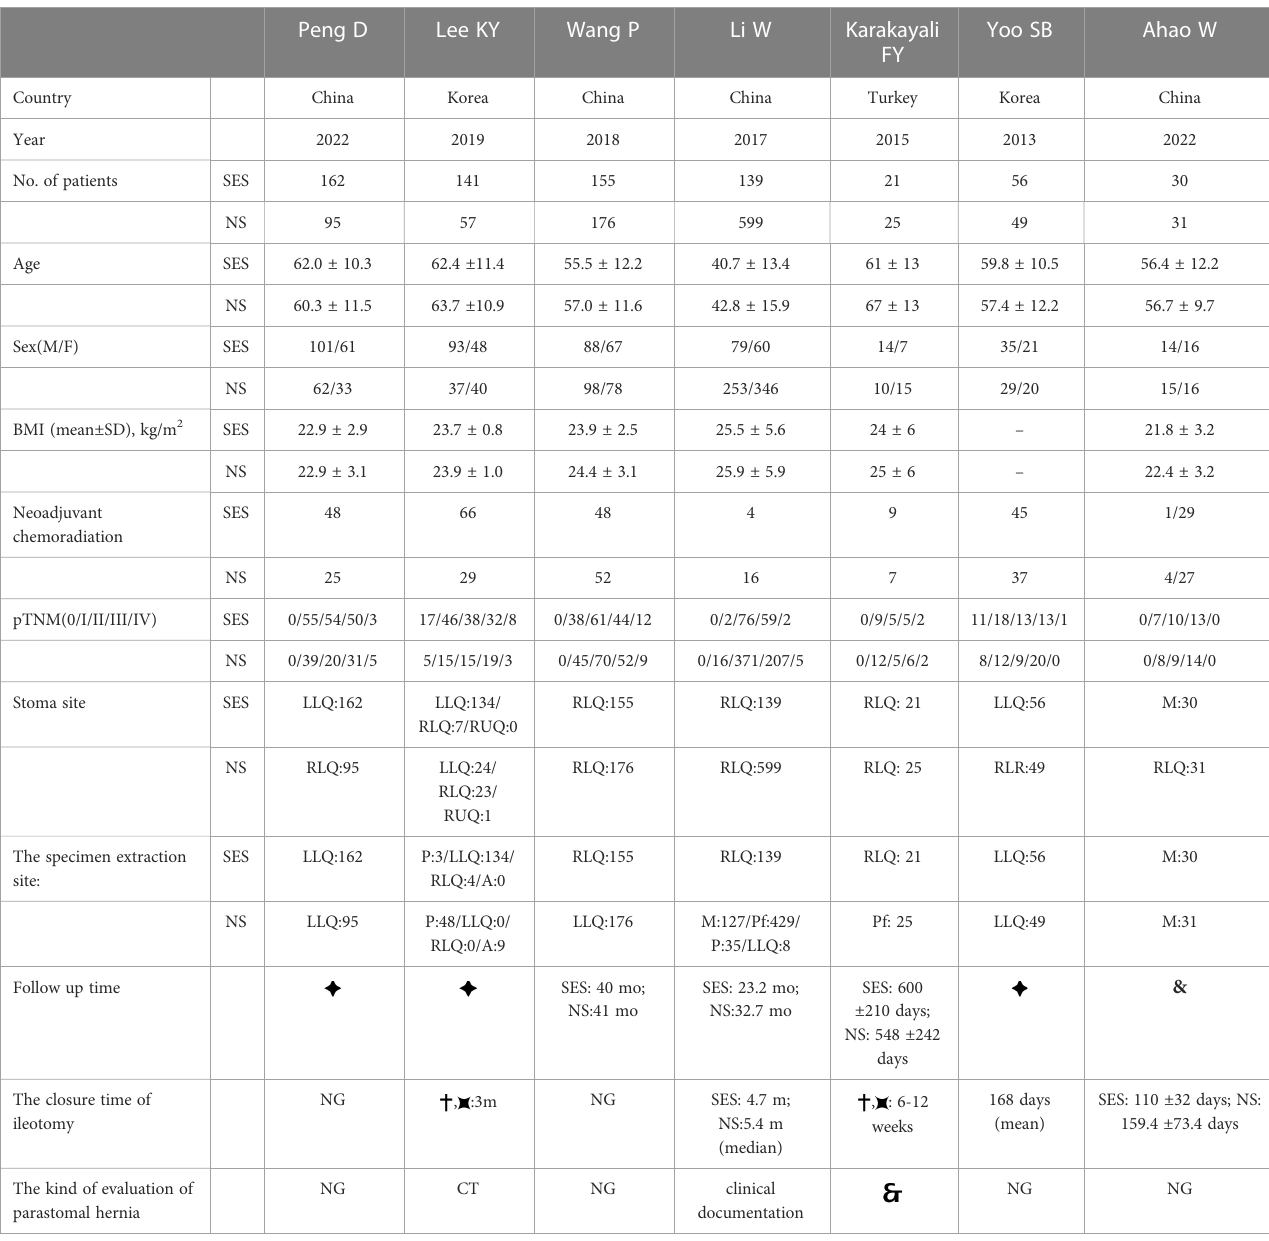
TABLE 1 Characteristics of the included studies.